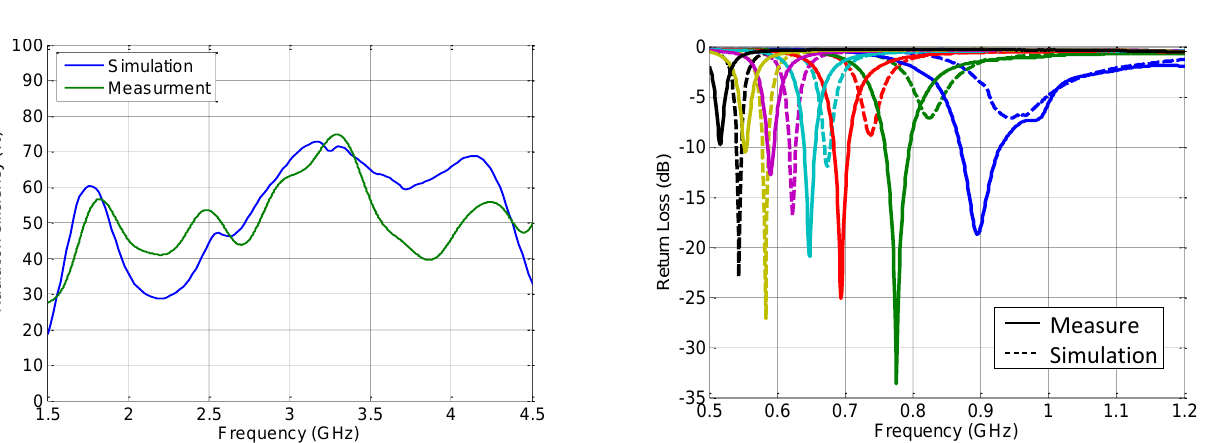
Figure. 6. Comparison of the antenna radiation efficiency